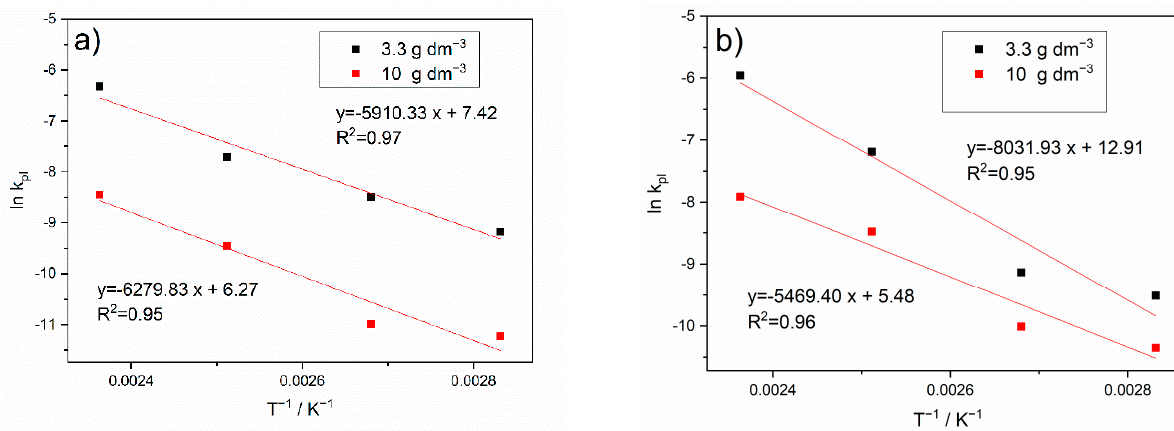
Figure 4. Arrhenius plots for ( a ) Zn and ( b ) Mn.